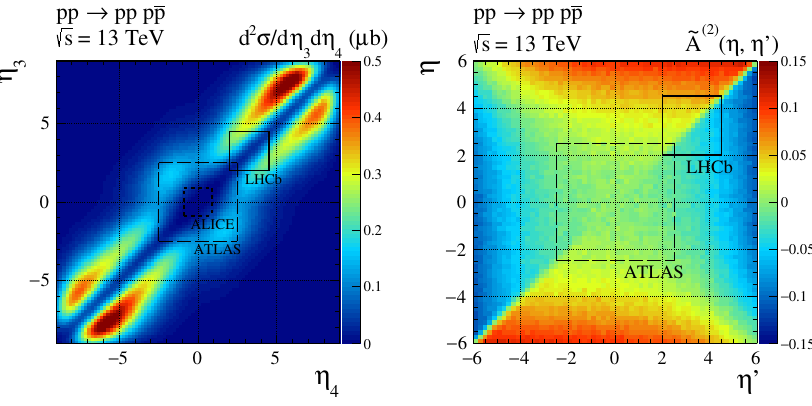
Figure 6. The two-dimensional distribution in ( η 3 ,η 4 ) for the di ff ractive continuum p ¯ p production for the full phase space and the asymmetry (cid:101) A (2) ( η,η (cid:48) ) [see Eq. (16)] at of the coverage for the ALICE, ATLAS and LHCb experiments are